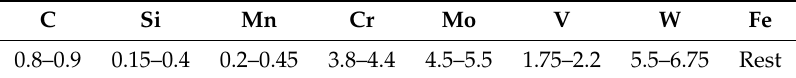
Table 1. Elemental composition (wt%) of W6Mo5Cr4V2 high-speed steel powder.